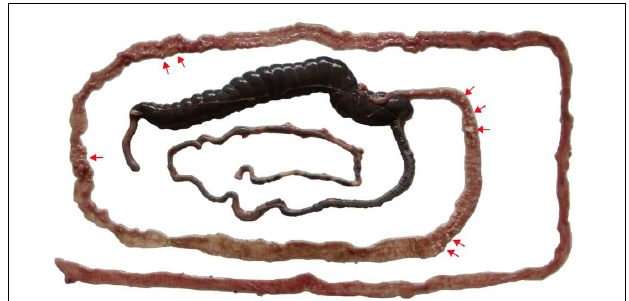
FIGURE 3 | Pathological changes of white nodules (red arrows) of the lower jejunum and ileum of a rabbit at 9 days after inoculation with 5 × 10 3 transgenic E. intestinalis